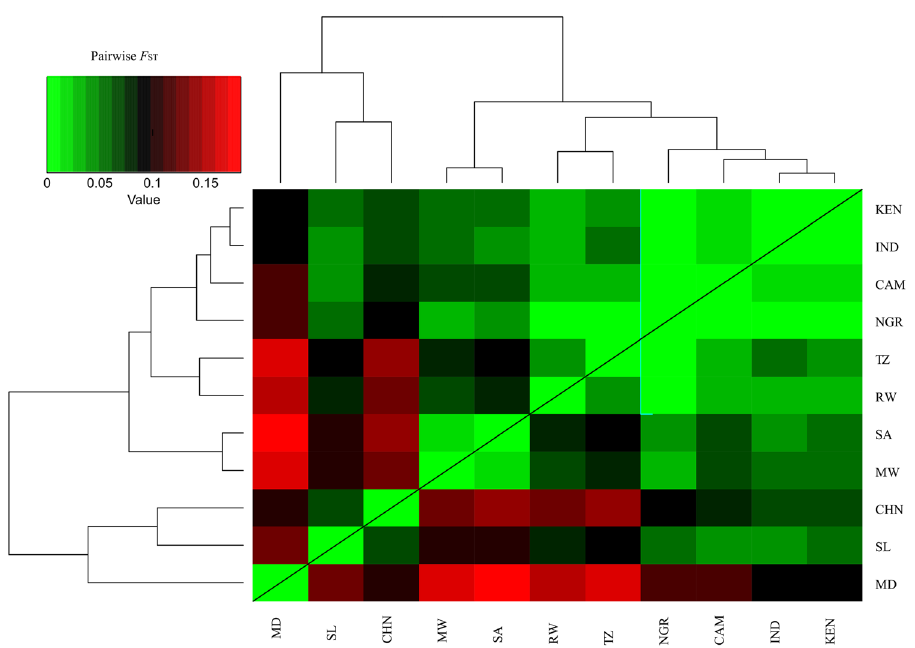
Figure 3. Heat map depicting pairwise F ST estimates between countries. The map was generated by using the ‘heatmap.2’ function from the gplots package in R using pairwise F ST matrix calculated in StAMPP. Populations (countries) are across the X- and Y-axis, with each square indicating the F ST estimate between the two respective individuals. The magnitude of the genetic differentiation is indicated by the colour range. MD,